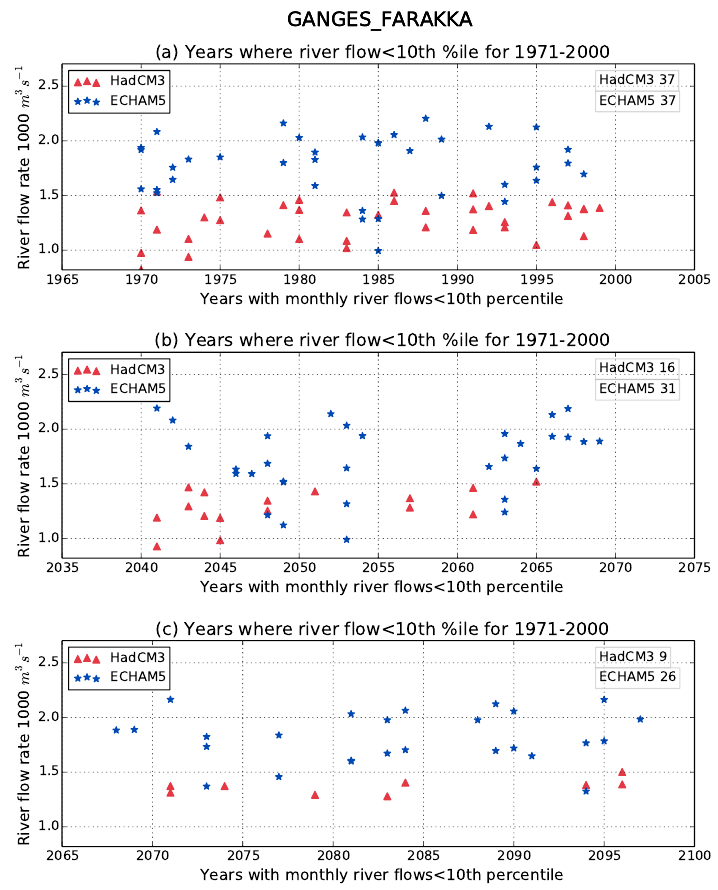
Figure 12. Comparison of the lowest 10% of monthly river flows at the Farakka Barrage on the Ganges River against the 10th percentile for the 1971–2000 period for 1971–2000 (top panel), 2050s (middle panel) and 2080s (bottom panel) for HadCM3 (red triangles) and ECHAM5 (blue stars). Each star or triangle represents a month within the 30-year period where the value is less than the 10th percentile of the 1971–2000 period with the total number for each of the simulations given in the top right corner of each